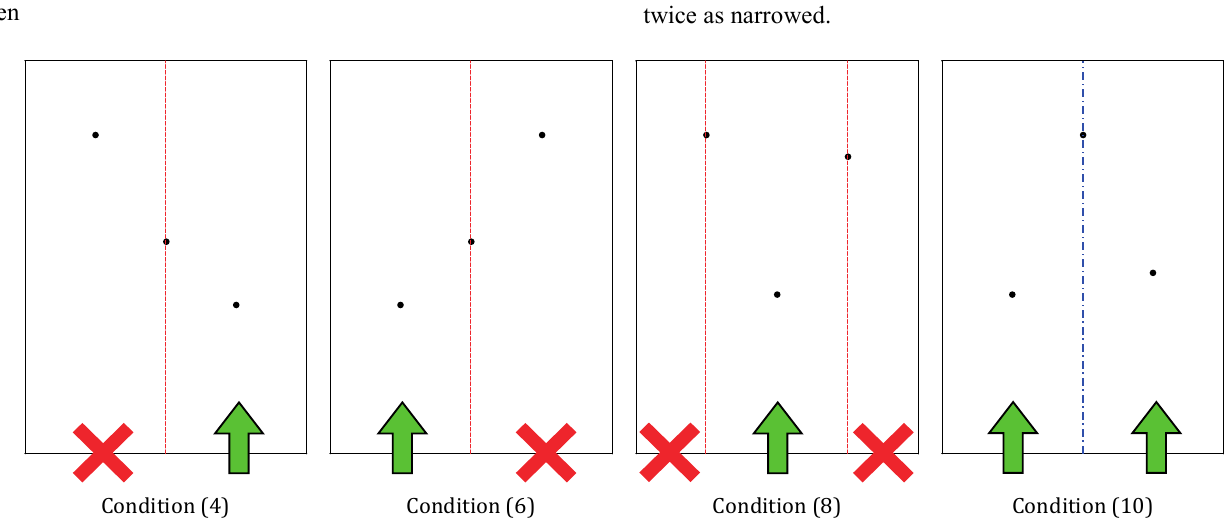
Fig. 5. The four possible cases and their outcomes issued from one of conditions (4), (6), (8),